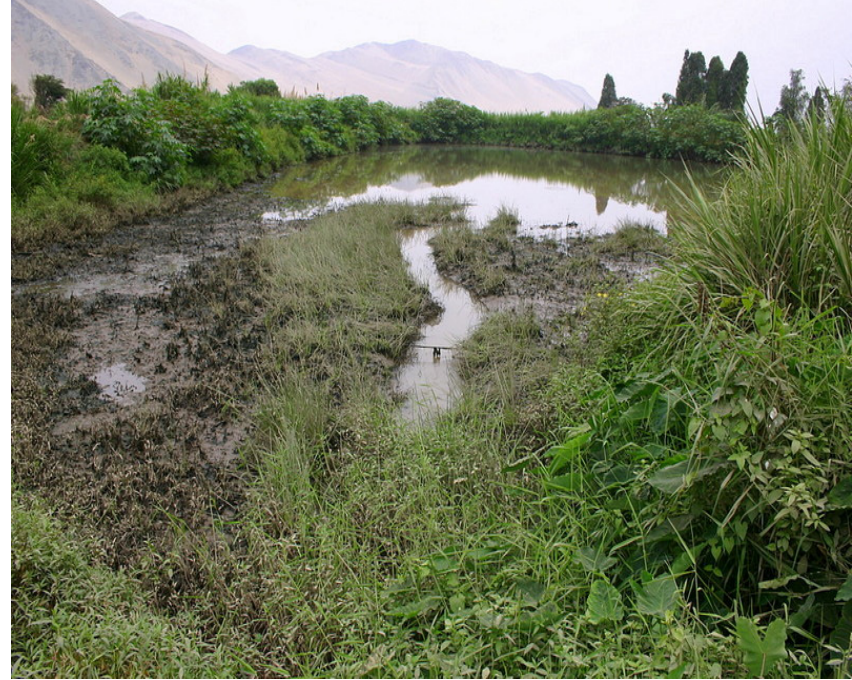
Water 2022 , 14 , x FOR PEER REVIEW Figure 10. Typical interior Supe Valley pool derived from low-valley areas intersecting the high water table.